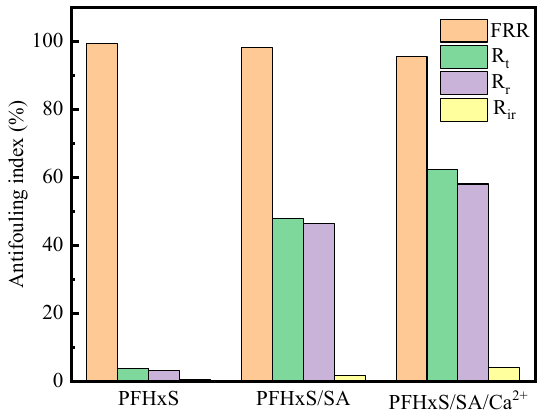
Figure 3. The relative antifouling indexes for HA-TFC i NFM under PFHxS/SA/Ca 2+ system.